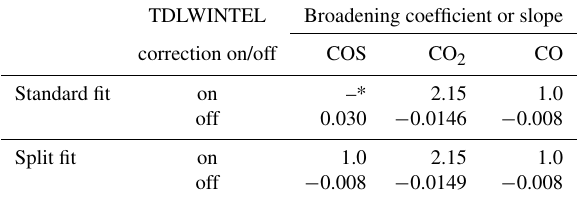
Table 4. Different water vapor correction strategies based on the software fitting parameters (standard or split fit) and with the TDL- WINTEL correction turned on or off. When the TDLWINTEL cor- rection is turned on the values indicate the broadening coefficient used for the different species, and when it is turned off the values indicate the slope of the correction curve as determined in Fig. 3 with y = slope × H 2 O + 1 with H 2 O in percent and y the wet / dry ratio of the